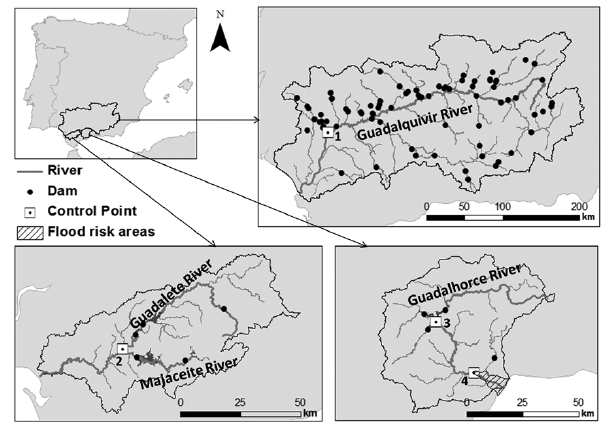
Figure 1. Location of the Guadalquivir, Guadalete and Guadal- horce rivers basins and location of the dams and control points.